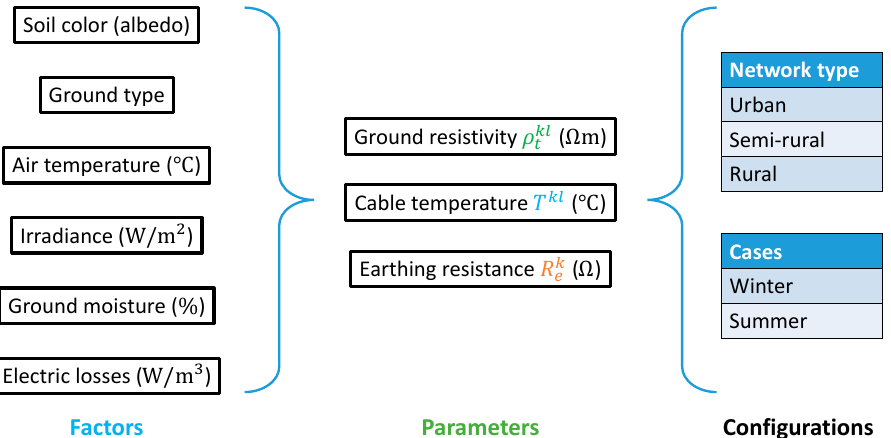
Figure 13. Factors, parameters, and configurations for the simulations regarding voltage profile. The link between the factors, parameters, impedances, and voltage profile is given in Figure 7. The factors have an impact on the parameters. As the factors are interrelated, so are the parameters. Several configurations (three networks and two cases) are considered to have consistent parameter values.